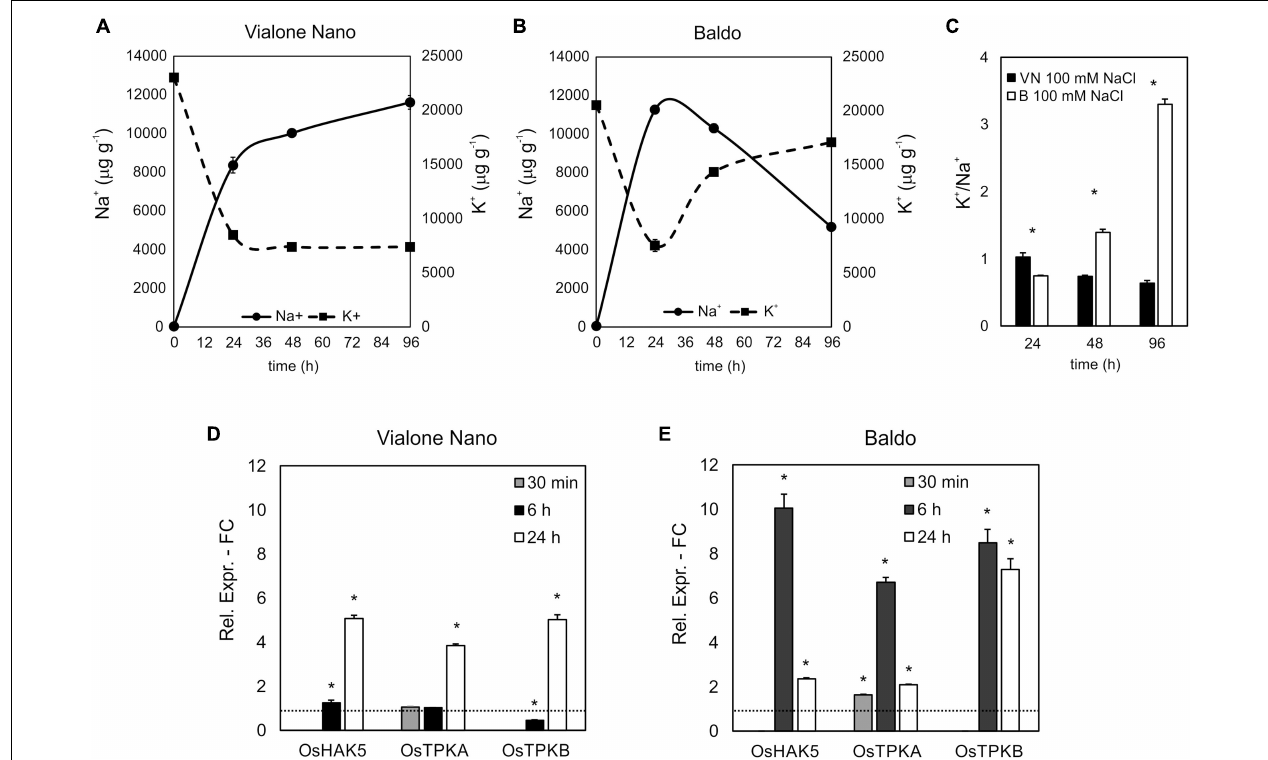
FIGURE 3 | [K + ] and [Na + ] content and ion channel genes regulation. K + (A) and Na + (B) content in treated (100 mM NaCl) and untreated cells was measured, and the [K + ]/[Na + ] ratio was calculated (C) . (D,E) Expression profile of genes involved in K + uptake in the cytosol. Values represent the mean ± SE of three independent experiments. Asterisks indicate significantly different levels (respect to the control in D,E , or between the two cell lines in C ) according to Wilcoxon–Mann–Whitney’s test ( p <